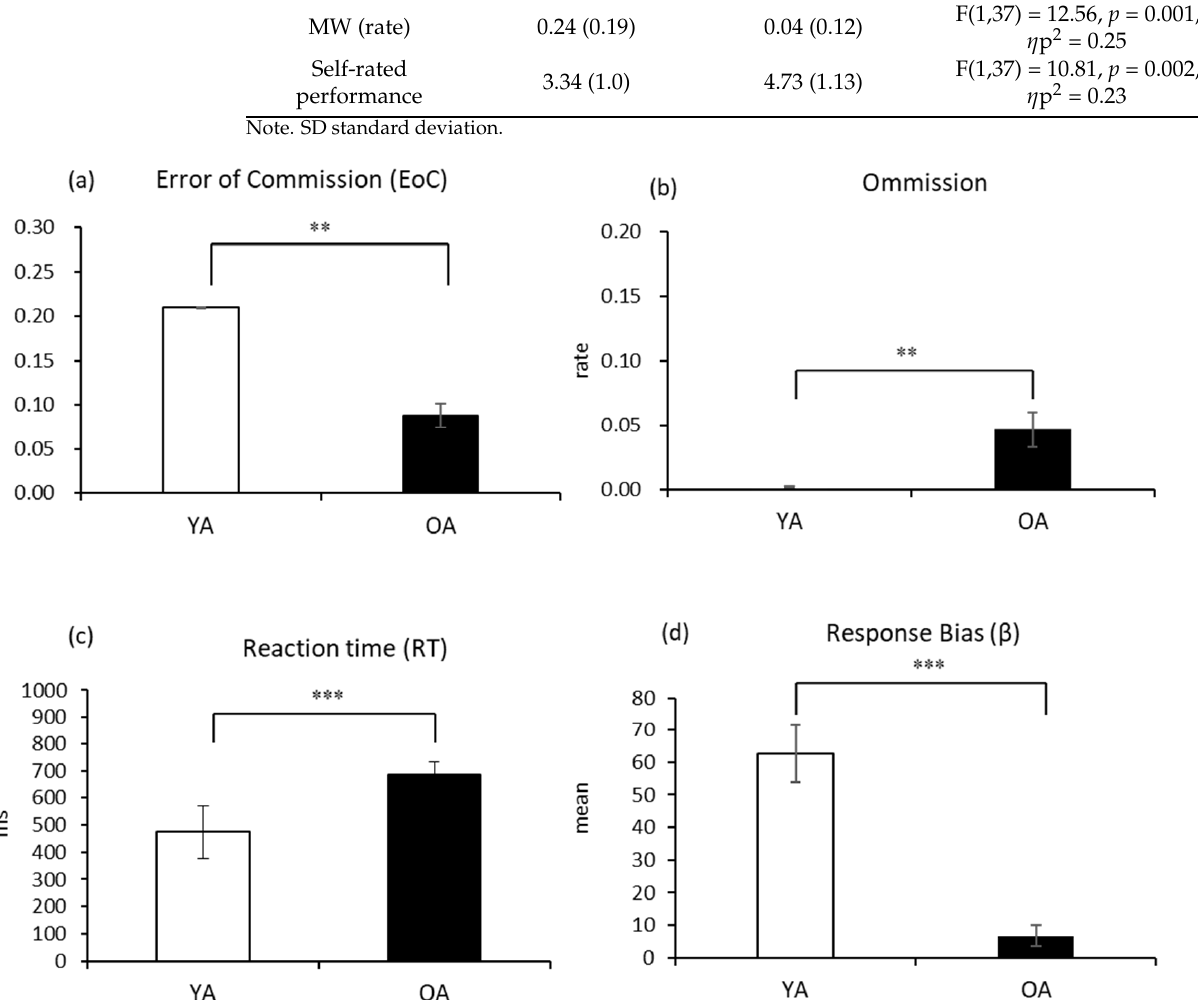
Figure 2. Age differences in types of errors committed and response patterns. ( a ) The propensity to commit EoC was higher for younger adults, while ( b ) omission was higher for older adults. ( c ) Mean RT was higher for older adults. ( d ) Response bias was greater for younger adults, indicating a stronger inclination in responding to GO targets. Error bars represent one standard error from the mean. YA: younger adults; OA: older adults; ** p < 0.01, *** p < 0.001.